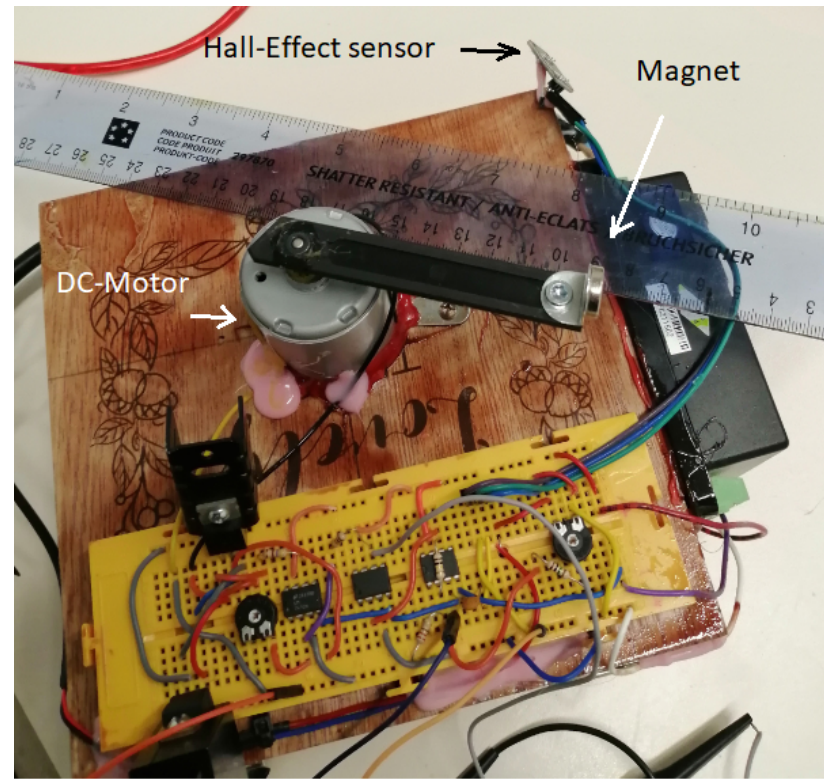
Figure 10. A low-cost experimental